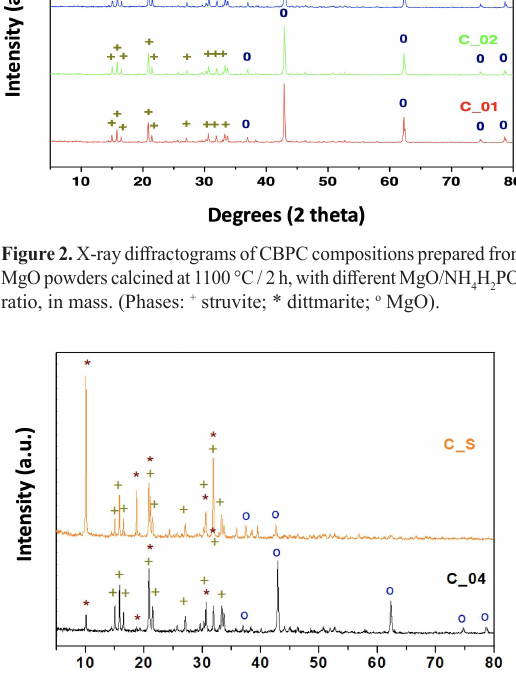
Figure 3. X-ray diffractograms of compositions C_S and C_04 prepared from MgO powders calcined at 1100 °C / 2 h, with different MgO/NH H PO ratios, by mass. (Phases: + struvite; 4 2 4 * dittmarite; o MgO).